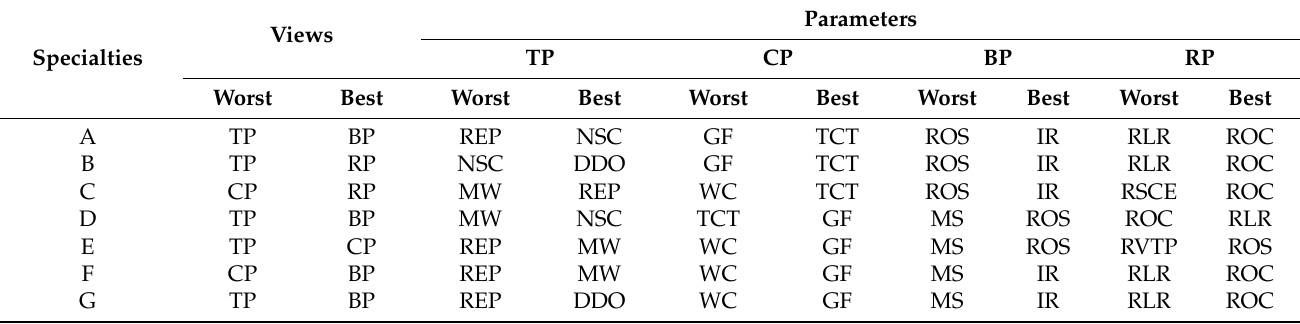
Table 6. The best and worst